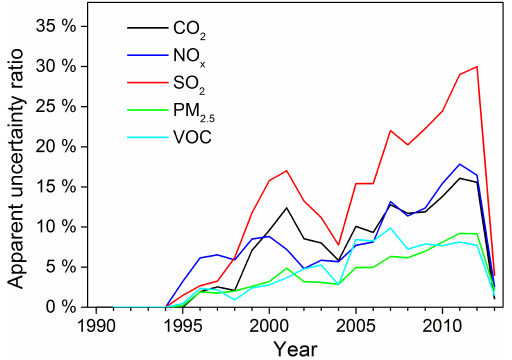
Figure 4. Apparent uncertainty ratio in China’s emissions during 1990–2013. Note that the emission uncertainties shown here are only those associated with energy